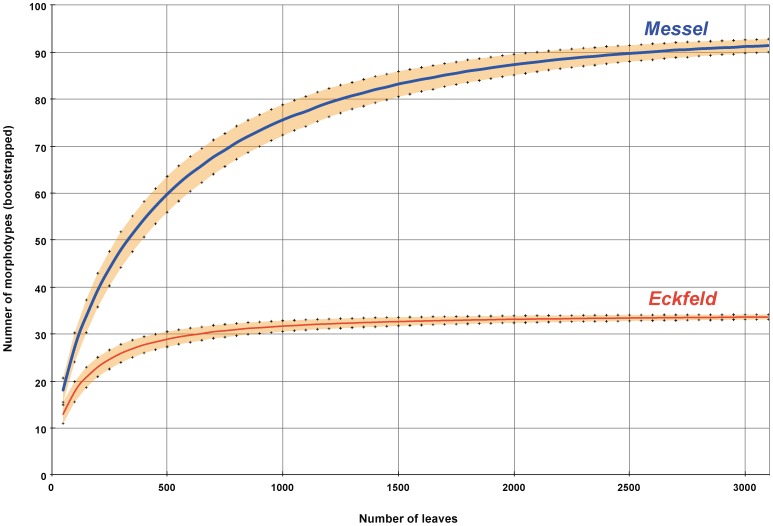
Rarefaction curves comparing the number of angiosperm leaf morphotypes at Messel and Eckfeld.The shaded area represents the standard error of the rarefaction calculated after [102]. The horizontal scale is reduced to 3000 for greater detail.